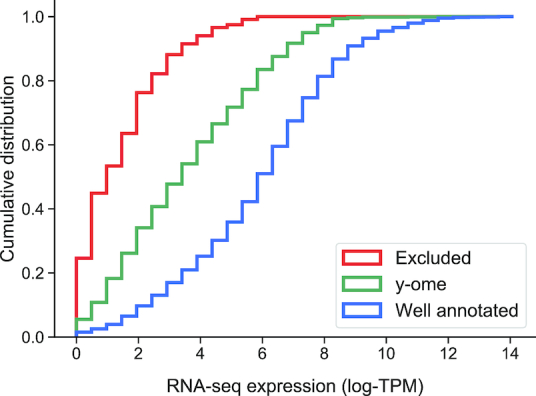
Average gene expression for all genes in a compendium of E. coli RNA-seq data. Cumulative distributions of normalized mean expression levels (mean log-TPM) for ‘y-ome’ (green), ‘Well annotated’ (blue) and ‘Excluded’ (red) genes across the 78 conditions surveyed in a compendium of RNA-Seq data.